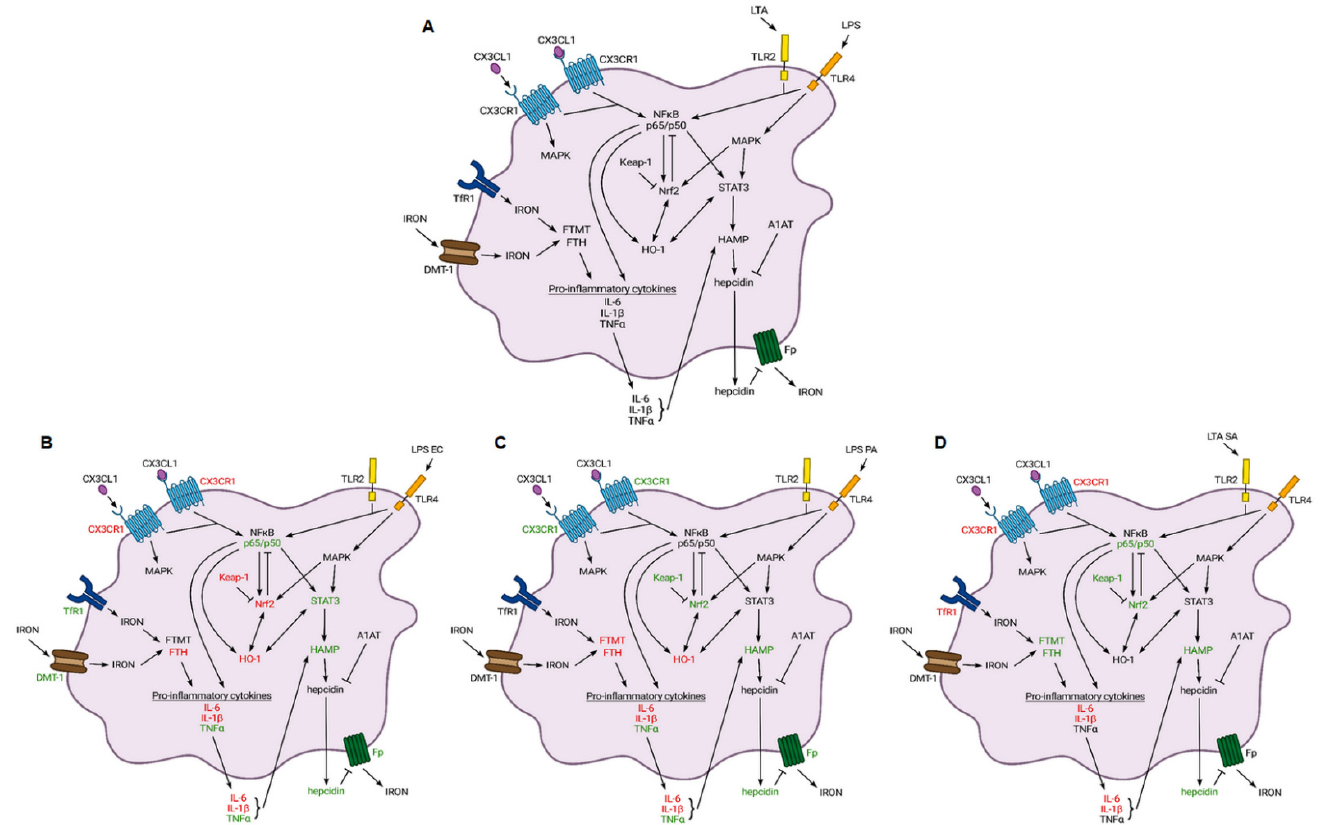
Figure 9. Cell signalling pathways regulated by CX3CR1 and TLR receptors and regulation of iron metabolism of THP-1 cells. ( A ) Fractalkine binds to CX3CR1 and activates NF κ B and MAPK pathways. The same signalling pathways are regulated by TLRs. NF κ B transcription factors regulate the transcription of Nrf2, STAT3, HO-1 and pro-inflammatory cytokines including IL-1 β , IL-6 and TNF α . Meanwhile, Nrf2, which is inhibited by Keap-1, provides feedback on NF κ B and HO-1 transcription. MAPK also modifies the activity of Nrf2 and STAT3 transcription factors by phosphorylation. PSTAT3 and pro-inflammatory cytokines increase HAMP transcription. Maturation of hepcidin is regulated by A1AT. TfR1 and DMT-1 function as iron importers and Fp act as iron exporter transmembrane protein. Fp is controlled by hepcidin. FTH and FTMT work as the cytosolic and mitochondrial iron storage proteins. ( B ) Alterations of the levels of signalling proteins and iron metabolism-related proteins in the presence of soluble fractalkine in E. coli LPS activated THP-1 cells. ( C ) Alterations of the levels of signalling proteins and iron metabolism-related proteins in the presence of soluble fractalkine in P. aeruginosa LPS activated THP-1 cells. ( D ) Alterations of the levels of signalling proteins and